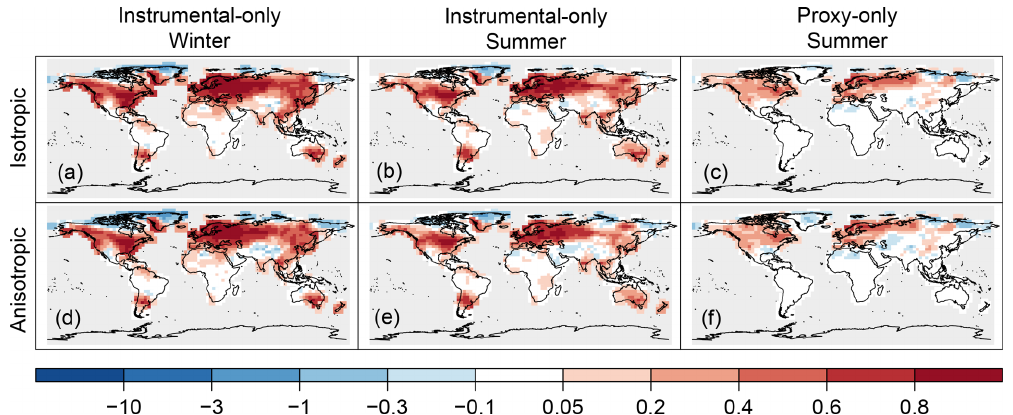
Figure 3. Spatial skill of temperature reconstruction presented by RE values, assimilating only instrumental data (a, b, d, e) and only proxy records (c, f) . Comparing the skill of the reconstruction using isotropic localization function (a–c) versus an anisotropic localization function (d–f) . Skill in the winter season (a, d) and in the summer season (b, e, c, f) are shown.